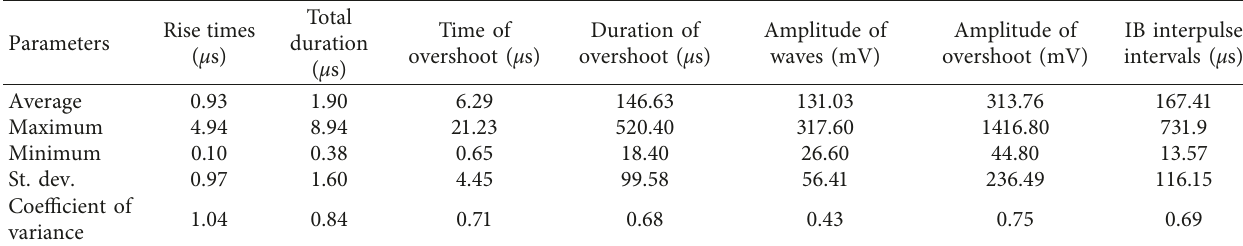
Table 2: Statistics features of IB pulses.